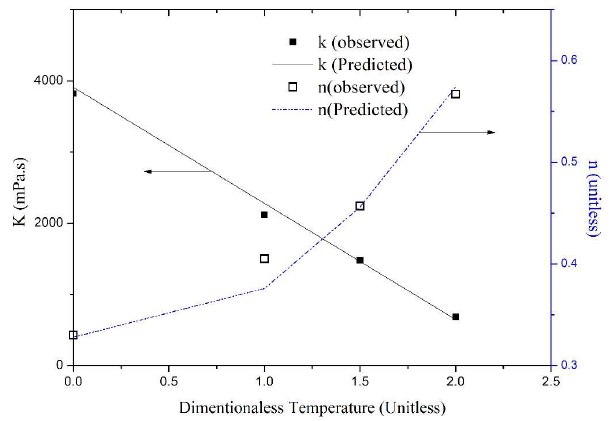
Figure 3. Effect of dimensionless temperature on the power law indices ( K and n) of sCO 2 foam.